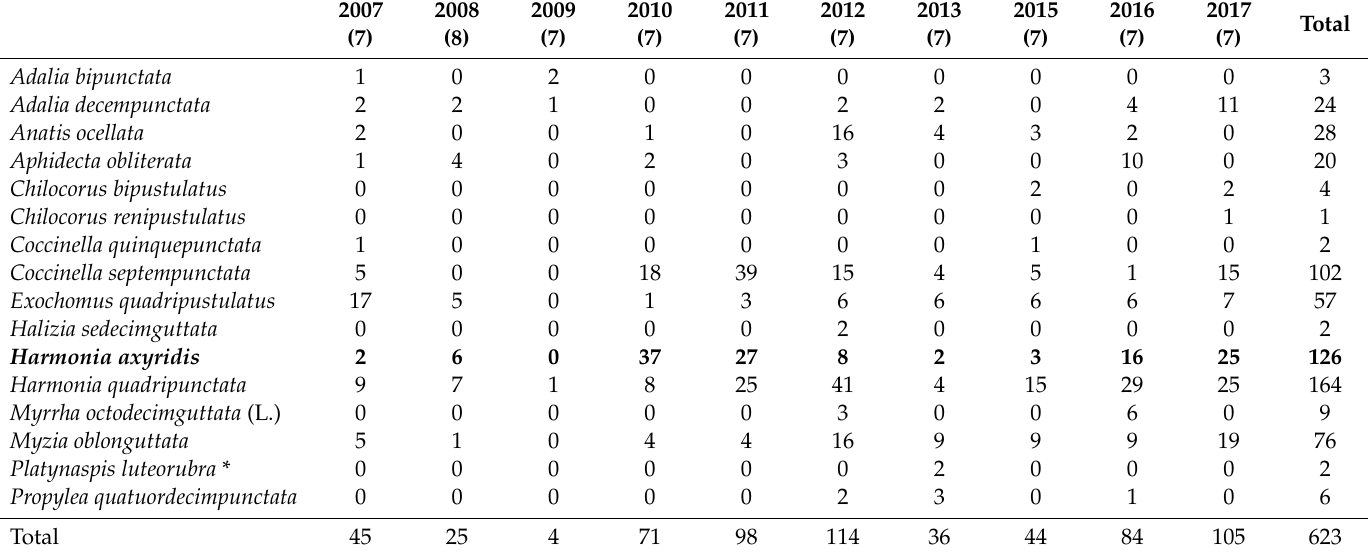
Table 3. Species and number of adult ladybirds collected at the five pine sites from 2007 to 2017. Numbers between parentheses indicate the number of collections. Ladybirds were not sampled in